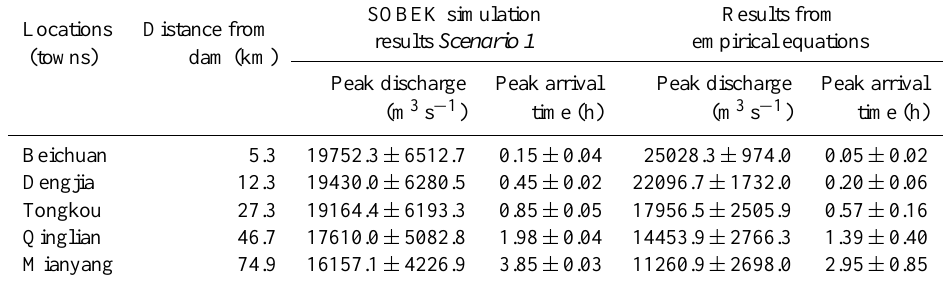
Table 7. Peak flood discharge and arrival time obtained from the SOBEK 1-D–2-D model and from the empirical Eqs. (1) and (2). SOBEK simulation Results from Locations Distance from results Scenario 1 empirical equations (towns) dam (km) Peak discharge Peak arrival Peak discharge Peak arrival (m 3 s − 1 )